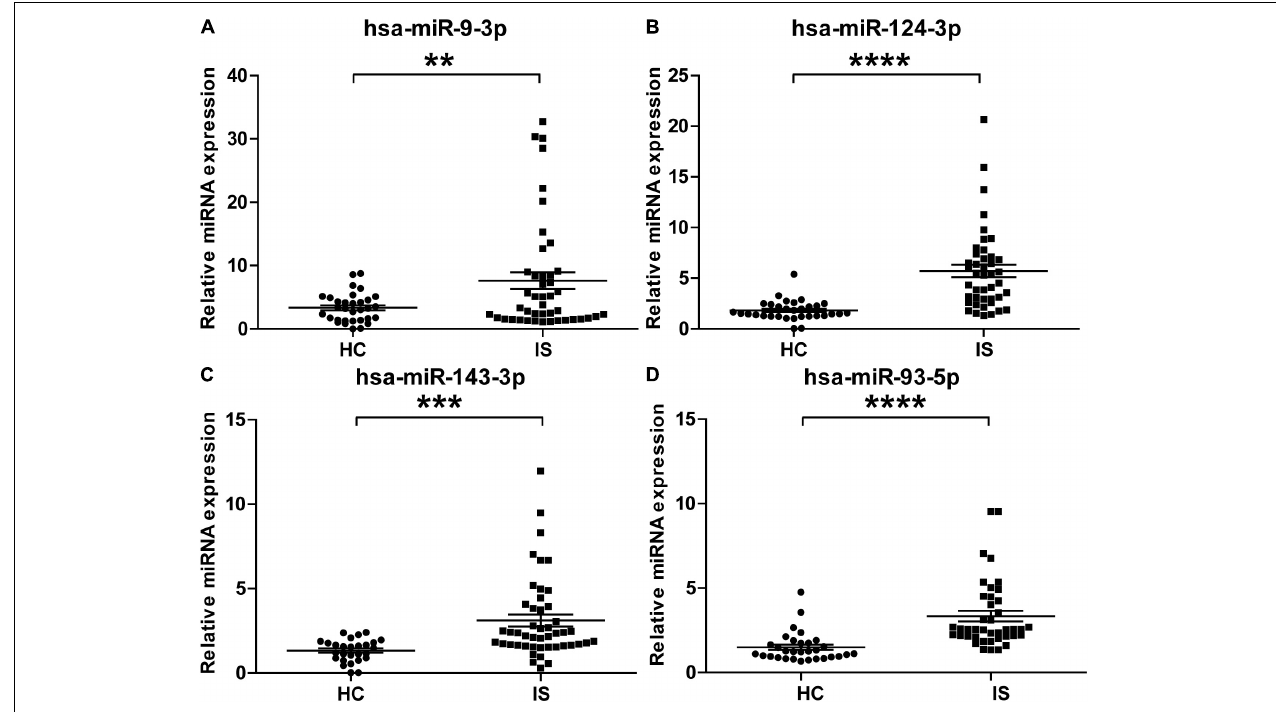
FIGURE 5 | Validation of the upregulation of the four brain-specific miRNAs in stroke patients. The expression of hsa-miR-9-3p (A) , hsa-miR-124-3p (B) , hsa-miR-143-3p (C) , and hsa-miR-93-5p (D) was assessed using qRT-PCR in the individual samples for small RNA sequencing. IS patients, n = 40, healthy controls (HCs), n = 33. The Ct value of target miRNAs was normalized against Cel-mir-39 and compared to the mean of healthy controls. Data are presented as Mean ± SEM. Unpaired Student’s test vs. healthy control (** P < 0.01, *** P < 0.001, **** P <